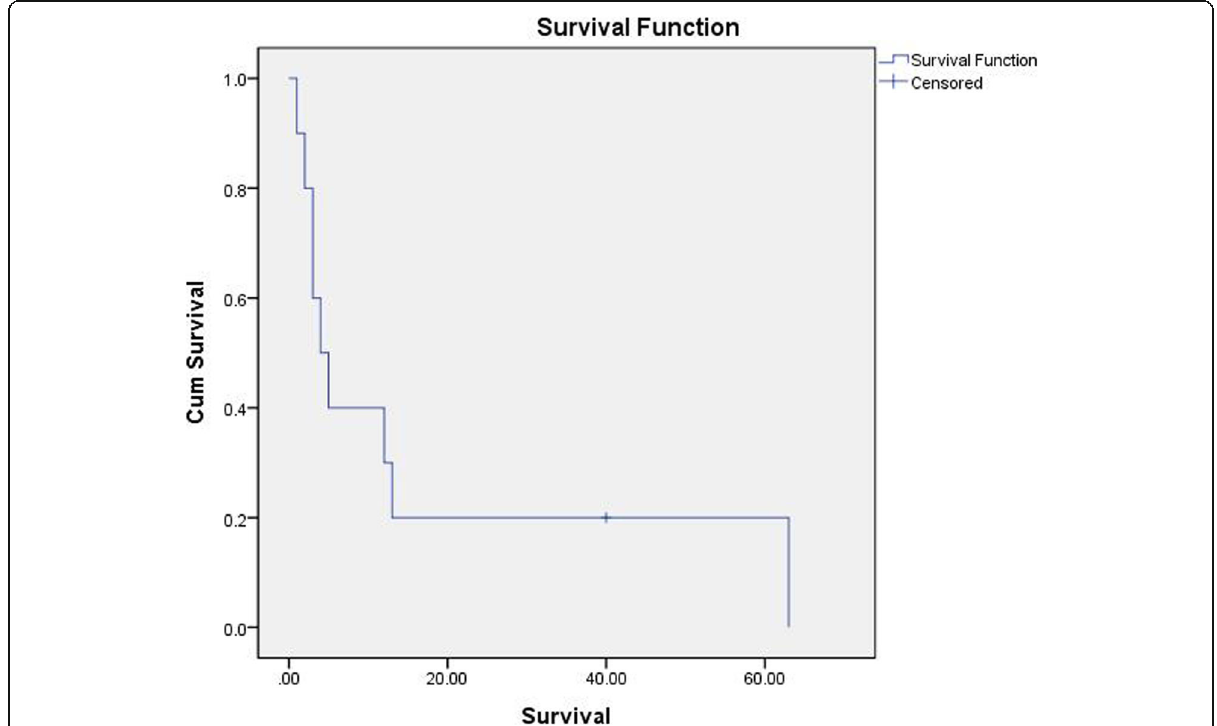
Fig. 2 Mean survival time among patients with